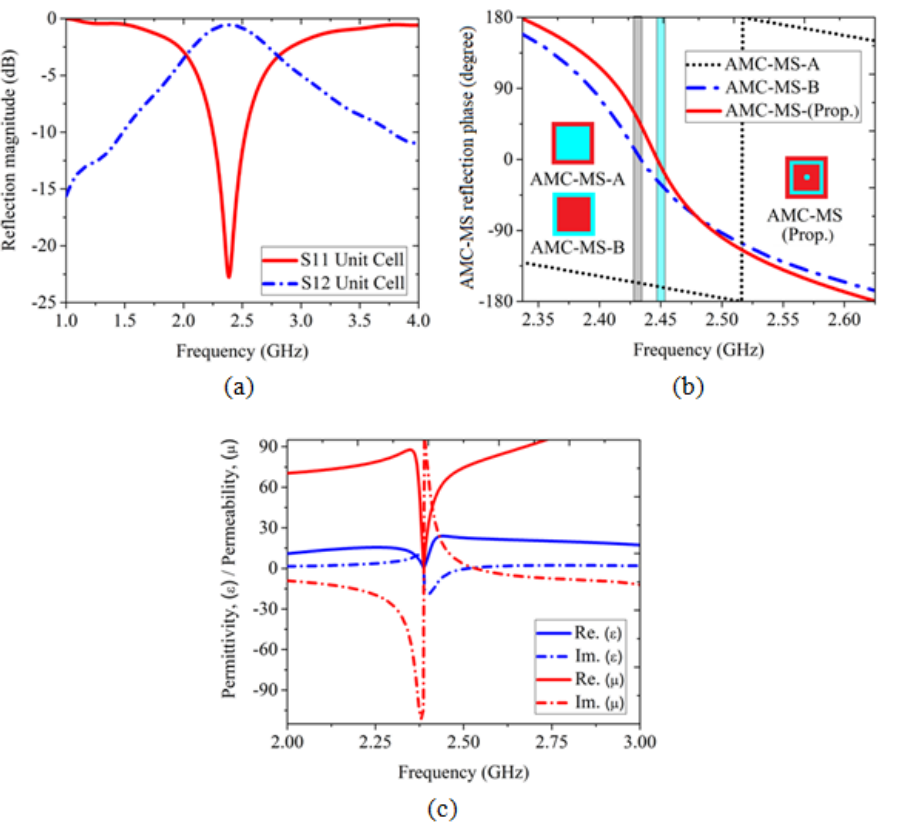
Figure 5. AMC-MS unit cell performance: ( a ) Reflection magnitude, ( b ) phase, and ( c ) permittivity ( ε ) and permeability ( µ ).